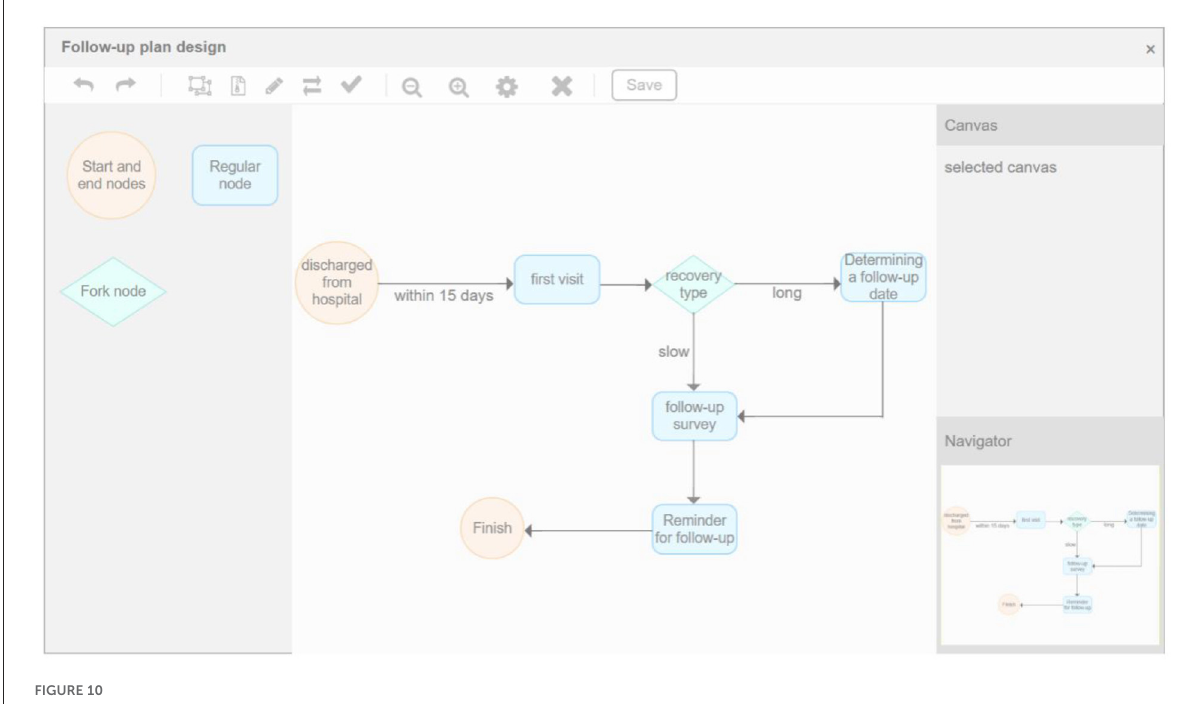
FIGURE10 Diabetes smart follow-up.